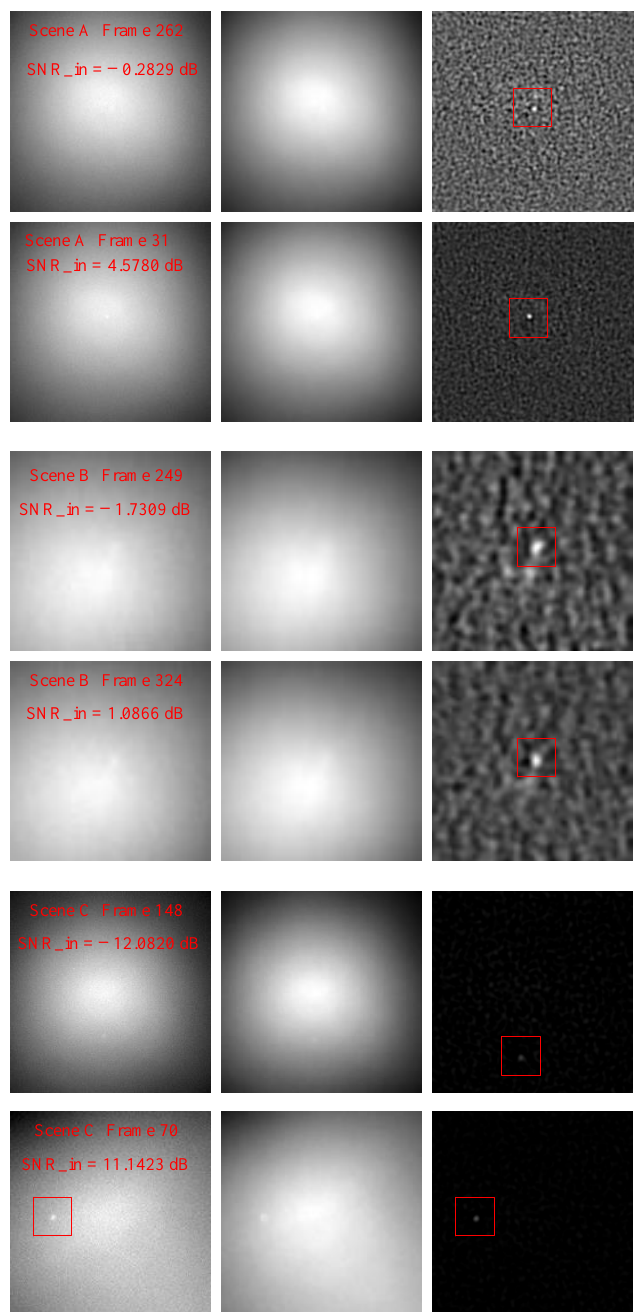
Figure 8. The background suppression effect of SPB when the target SNR is minimum and maximum of scenes A, B, and C.